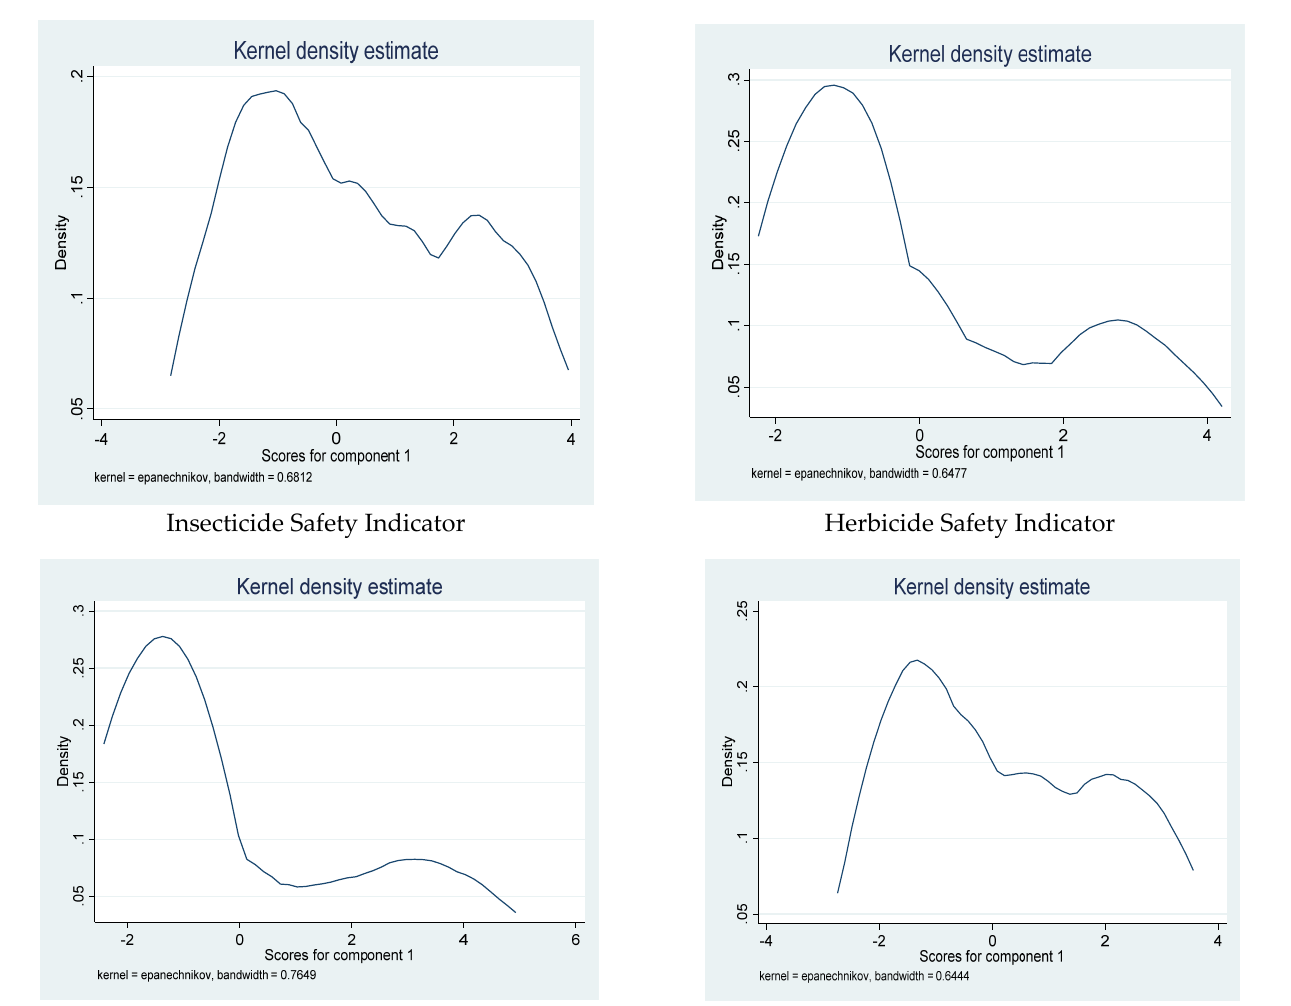
Figure 2. Cocoa farmers’ compliance with selected safety procedures when using agrochemicals.